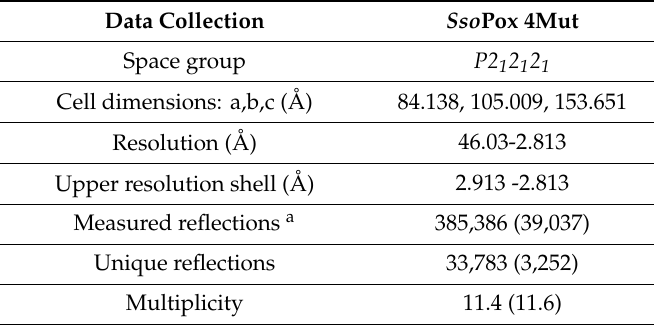
Table 4. Data collection and refinement of Sso Pox 4Mut crystal